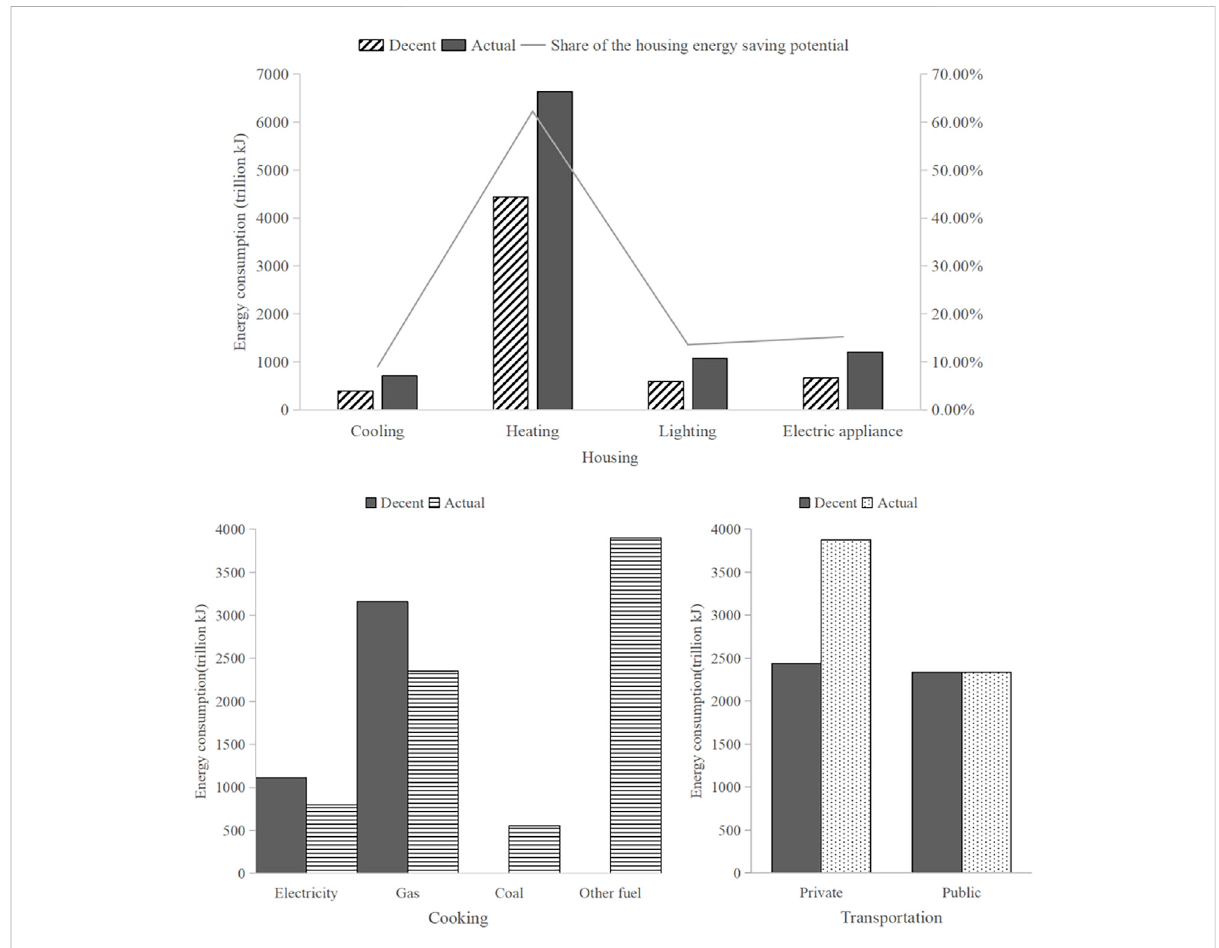
FIGURE 3 Direct energy consumption for transportation, cooking and